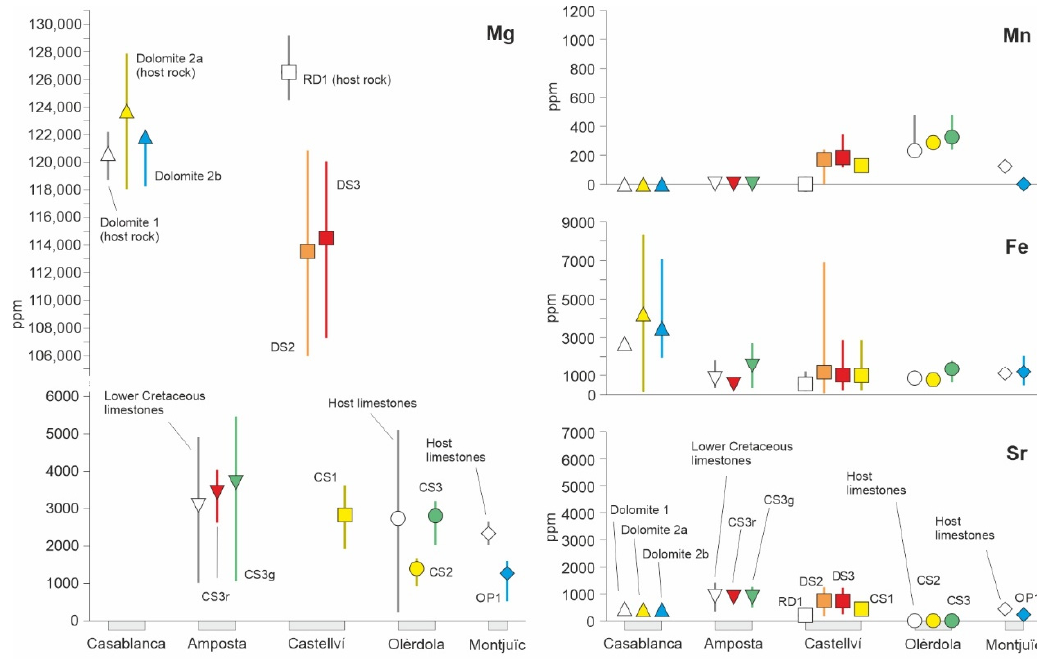
Figure 11. Maximum, minimum and mean Mg, Mn, Fe and Sr contents in ppm of the karst fills and host carbonates in the Casablanca and Amposta oil wells and in the Penedès Basin.